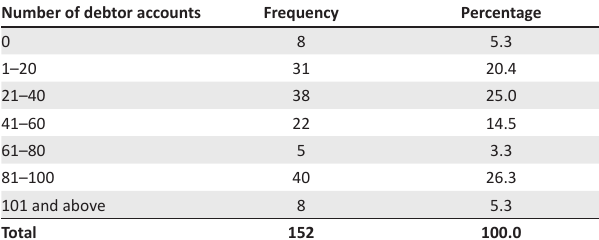
TABLE 1: Number of debtor accounts. TABLE 3: Bad debt relative to sales.